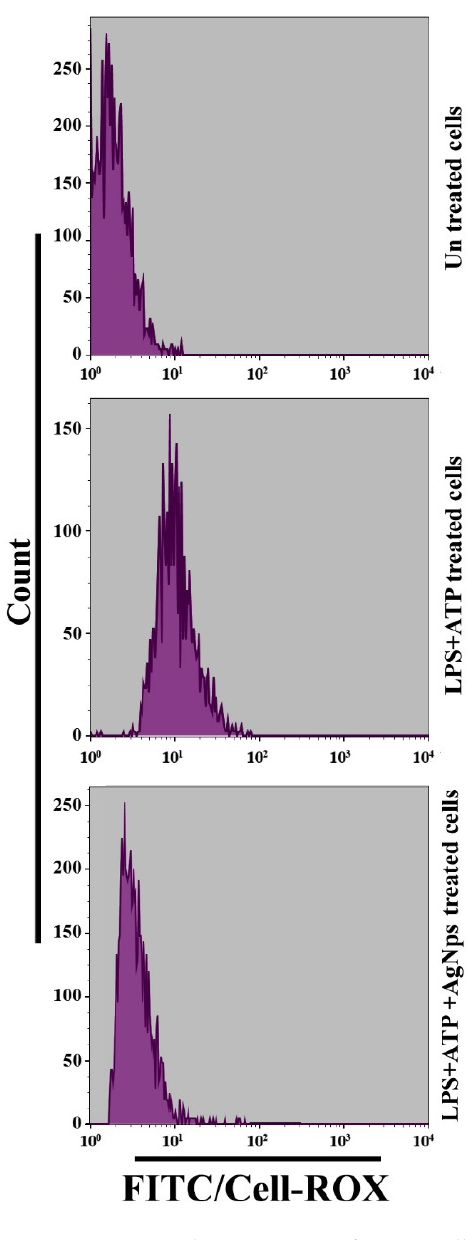
Figure 9. AgNPs reduce activation of ROS in cells. Cells were treated, or not, with LPS+ATP with and without treatment with 5 µ gmL − 1 AgNPs. The ROS accumulation was determined by flow cytometry.